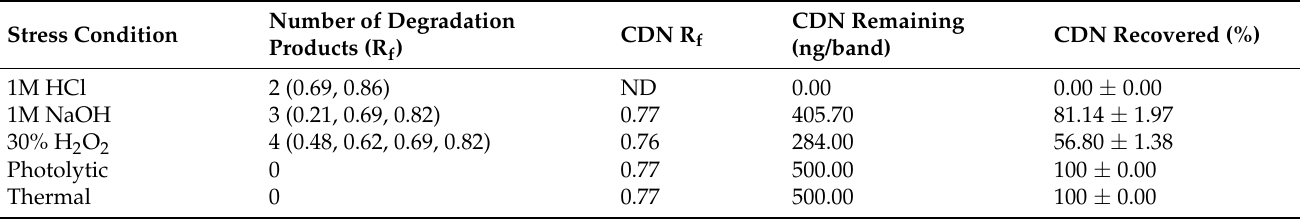
Table 6. Results of forced degradation evaluation of CDN at various stress conditions for current protocols (mean ± SD; n = 3).